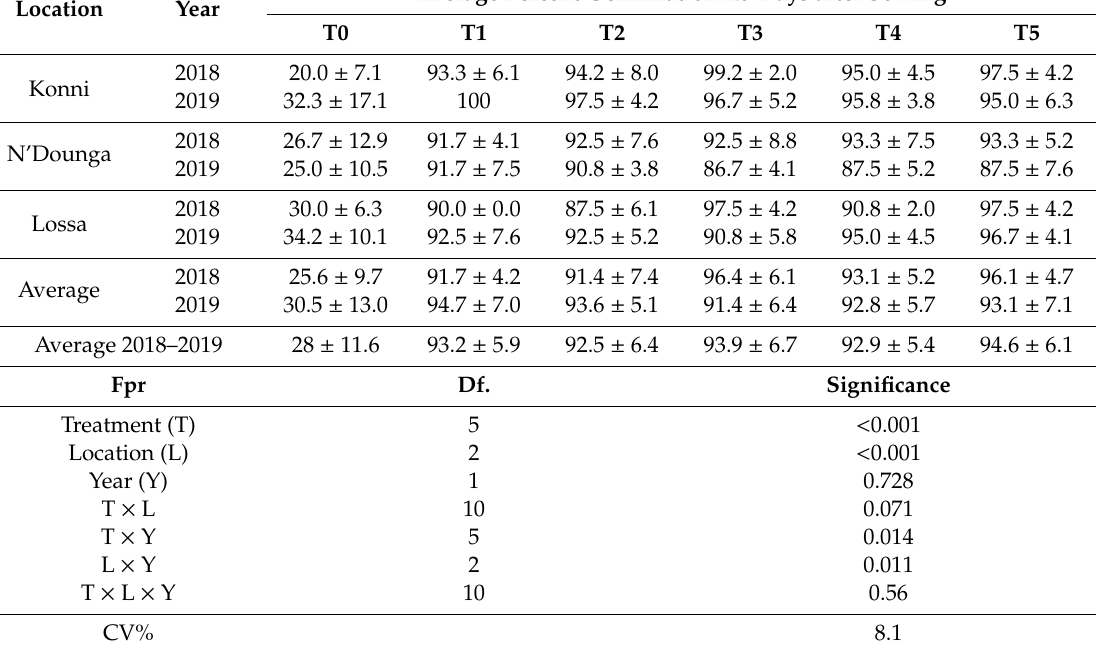
Table 4. E ff ects of treatments on percent germination 2.5 days after sowing. Averages of treatments and corresponding 95% confidence intervals are